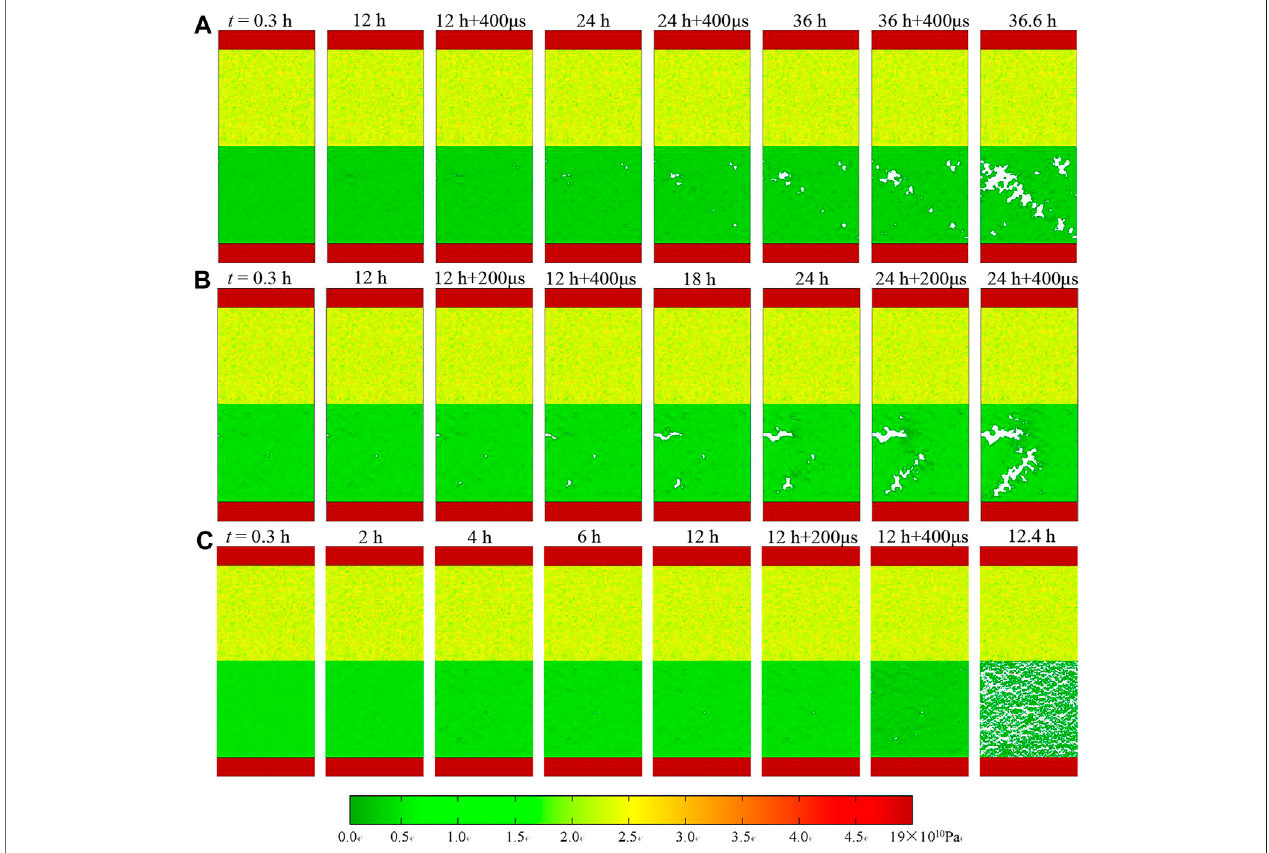
FIGURE 6 | Numerical results of elastic modulus under multi-stage creep test with dynamic disturbance: (A) creep stress = 15.18 MPa and impact high = 30 cm, (B) creep stress = 17.71 MPa and impact high = 30 cm, (C) creep stress = 20.24 MPa and impact high = 30 cm.